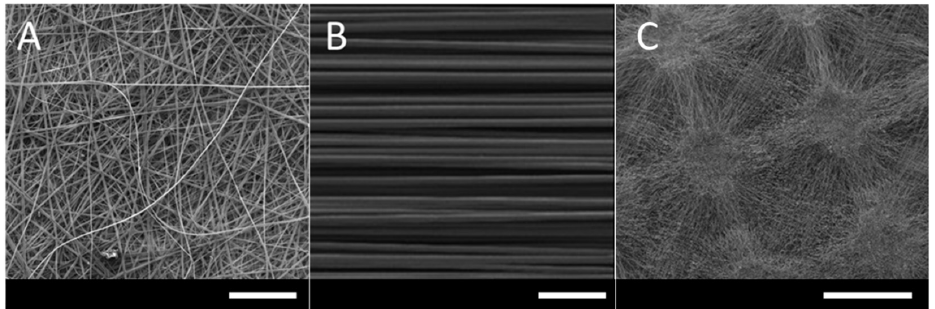
Figure 3. ( A ) Scanning electron microscopy image of fibres electrospun from a solution of Eudragit ®